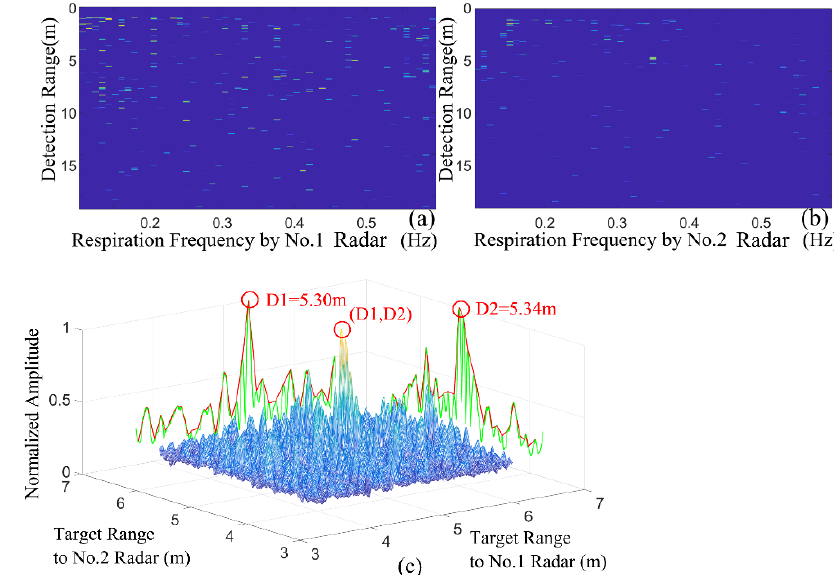
Figure 19. Measurement results for multistorey building. ( a , b ) The output range-frequency images using the normal FFT-based respiration detection methods using the echoes from a single radar. ( c ) The output 2D slice (range × range) image for the specific respiration frequency.